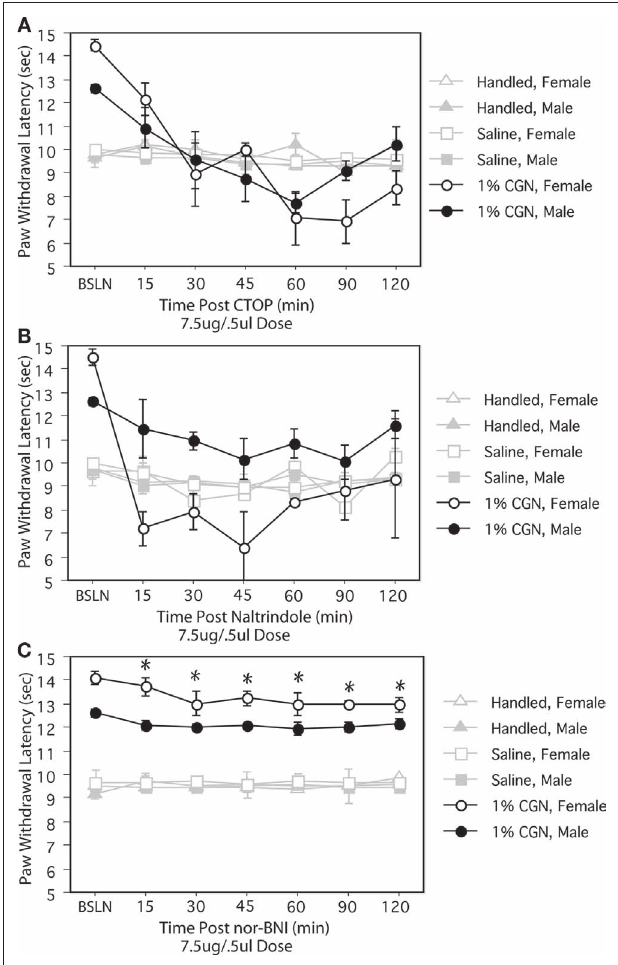
FIGURE 2 | (A) Intra-PAGvl CTOP signifi cantly reduced PWLs in neonatally injured males ( (cid:122) ) and females ( (cid:123) ) compared to controls. (B) Neonatally injured females displayed signifi cantly reduced PWLs following intra-PAGvl naltrindole that were not signifi cantly different from handled and saline controls. In males, intra-PAGvl naltrindole resulted in a slight decrease in PWLs. (C) Administration of nor-BNI into the PAGvl had no signifi cant effect on PWLs in neonatally injured or control animals. N = 6–8 rats per group/per sex. * indicates that PWLs for injured animals (collapsed across sex) were signifi cantly different from